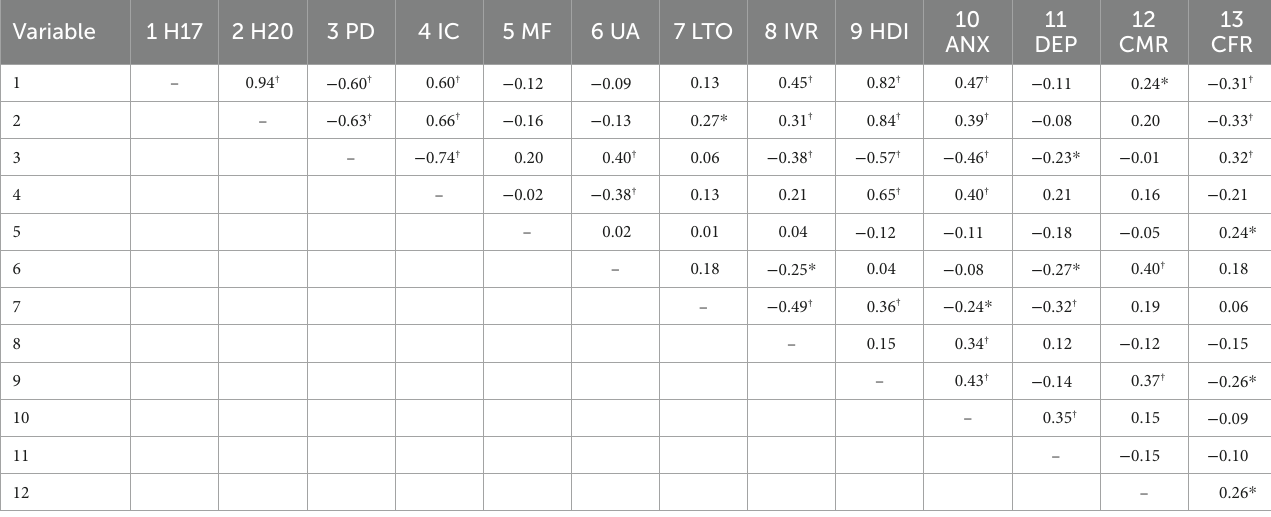
TABLE 2 Correlation matrix of associations between national happiness scores, Hofstede’s cultural dimensions, and potential confounding before and during the COVID-19 pandemic.